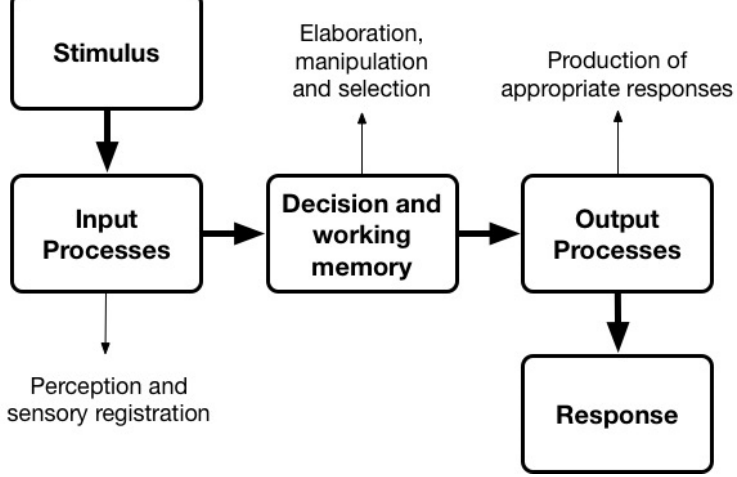
Figure 10. A basic human information processing model (figure is adapted from [77]).